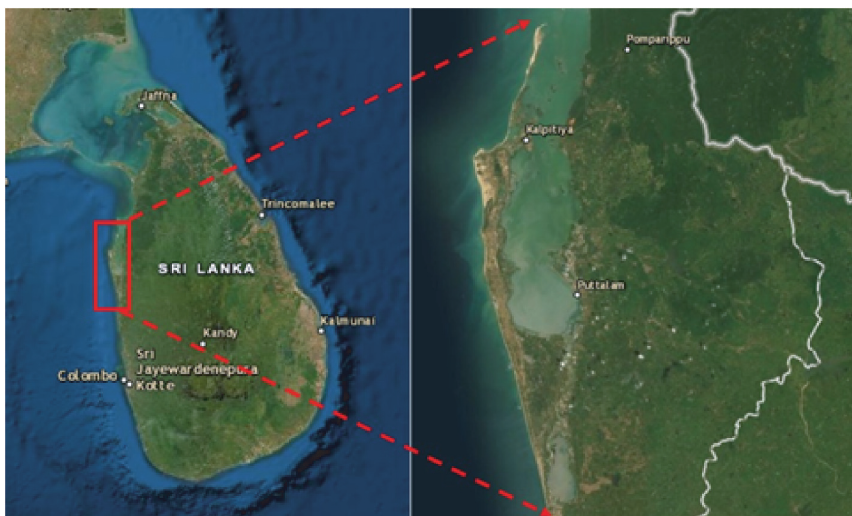
Figure 1: Study area of Pawan Danawi (image from https://earthexplorer.usgs.gov/).